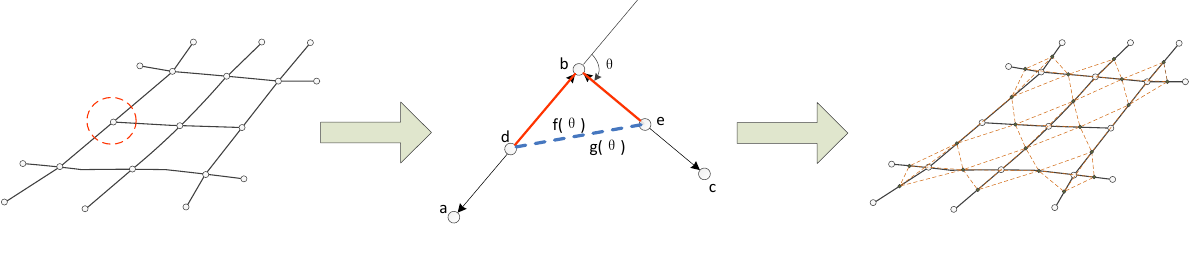
Figure 2. Construction of the auxiliary network based on road corners.